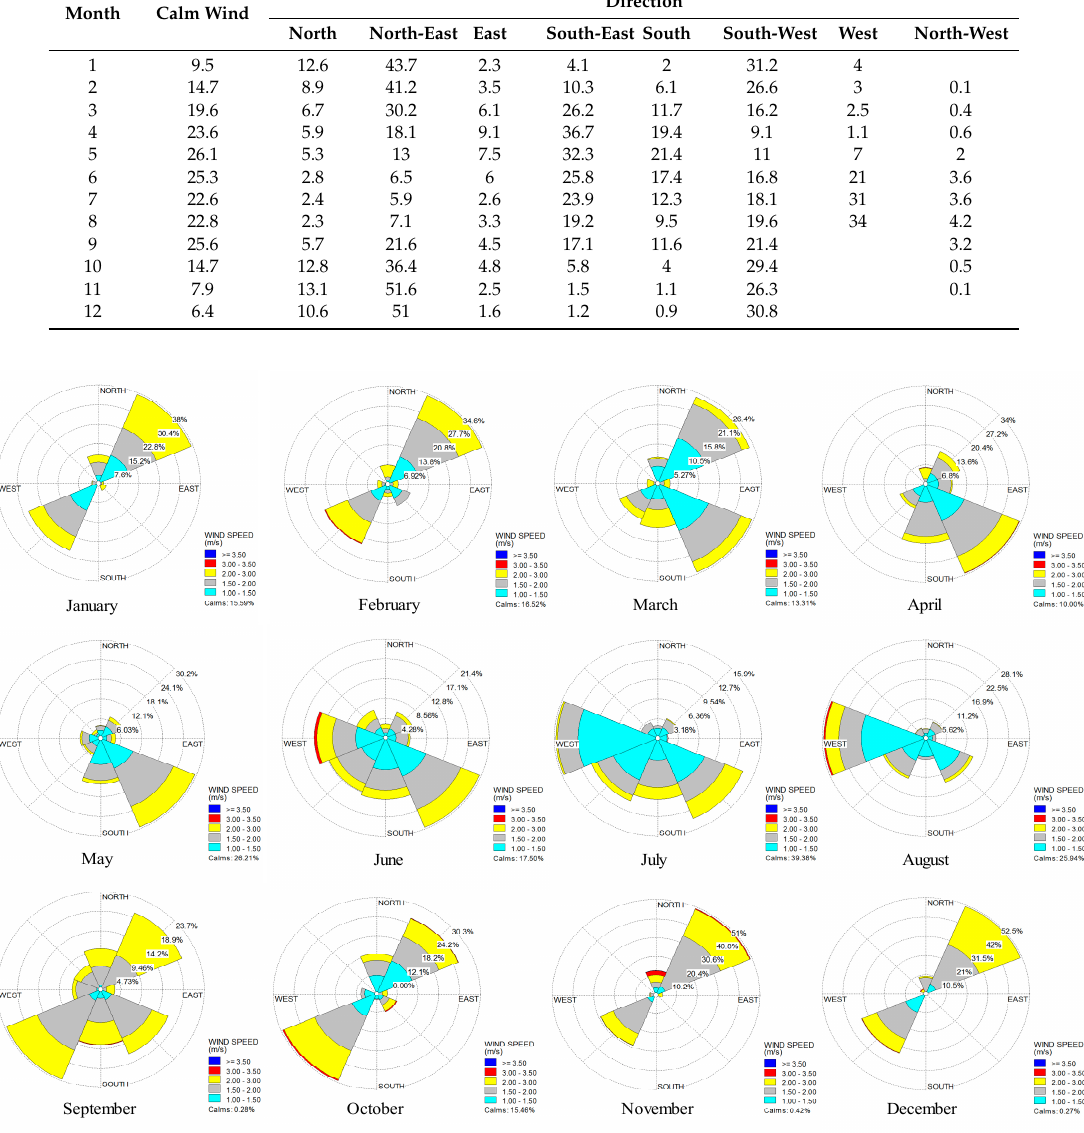
Figure 2. The wind speed frequency distribution and the “wind calm” (%) based on directions.